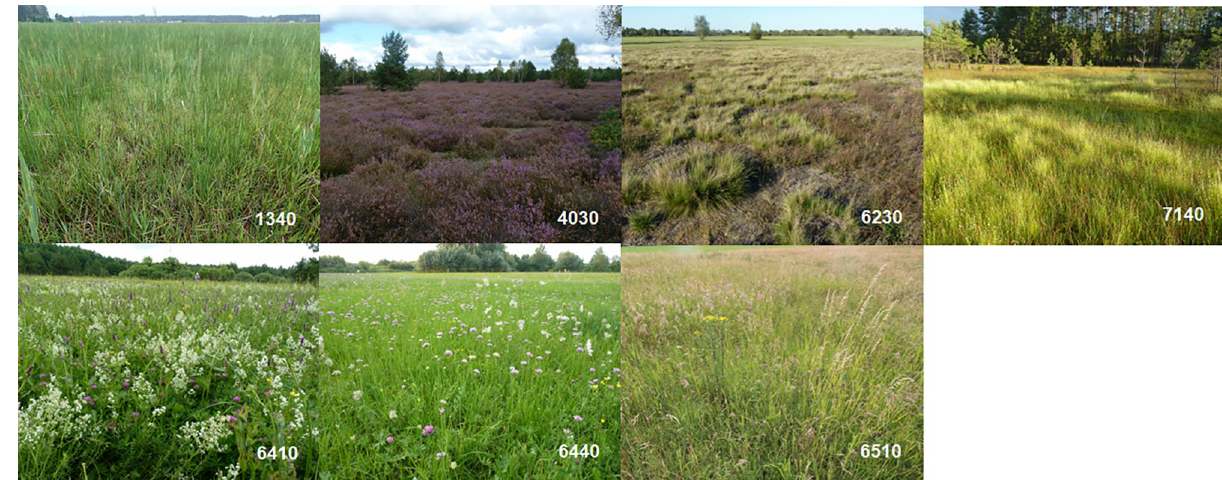
Figure 1. The images of analysed Natura 2000 habitats. The full names of the habitats are given in Table 1. Figure created by the authors using Inkscape (https:// inksc ape. org). Pictures of the habitats were taken by the authors of the